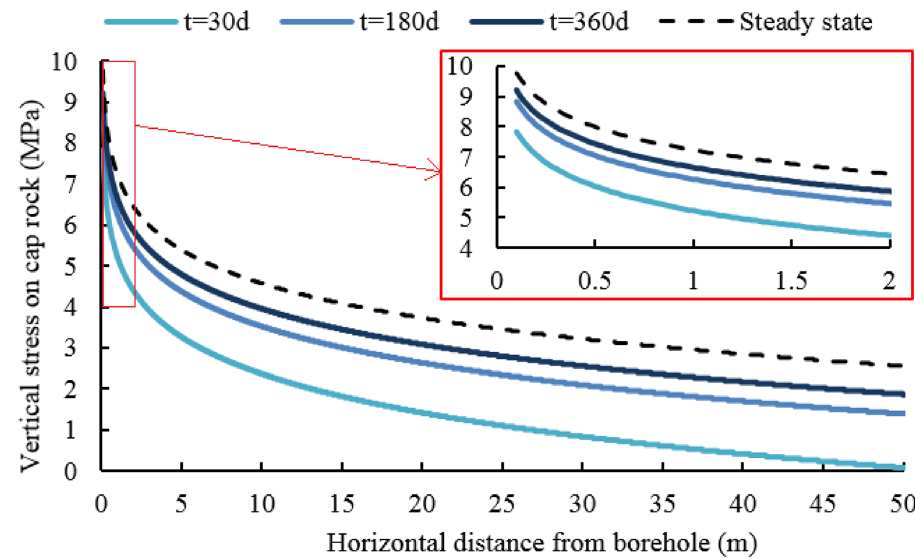
Fig. 2 Vertical stress formed by the swelling of CO 2 injection at the interface between coal